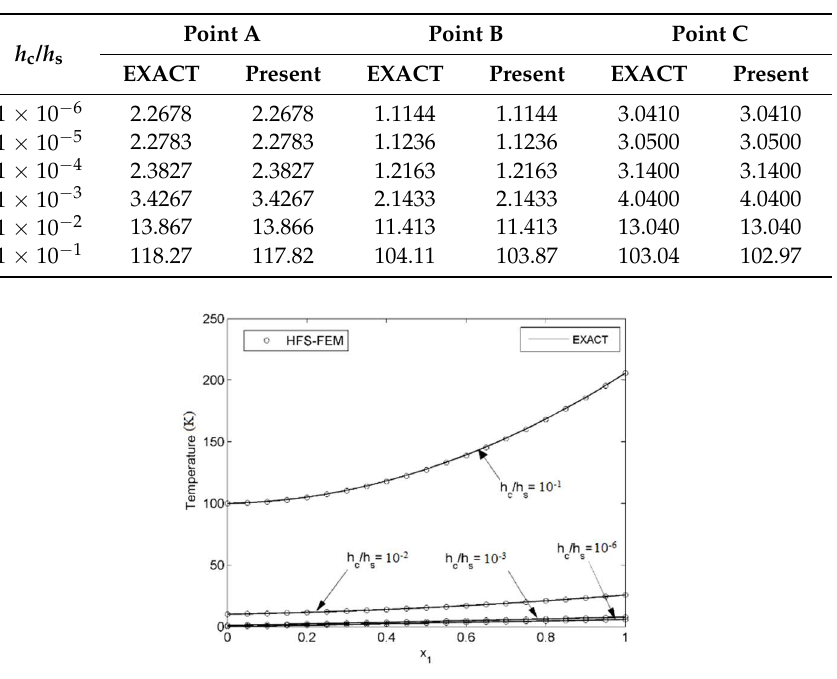
Figure 7. Variation of temperature along the interface for η = 1000 h c / h s in the second